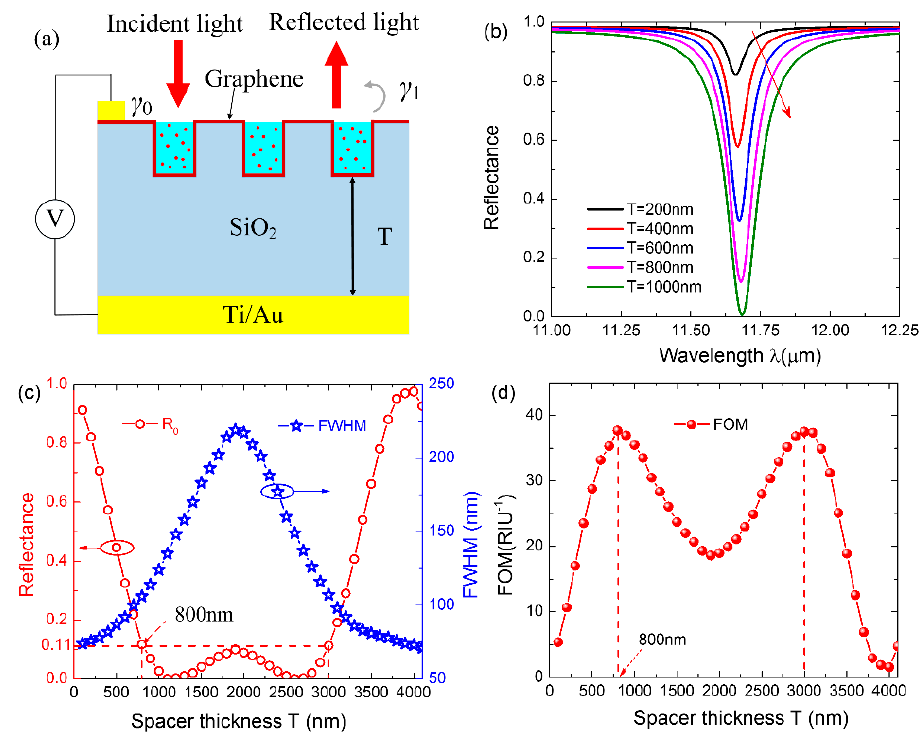
Figure 5. ( a ) Schematic of the reflection-type CGDNC infrared sensor; ( b ) The reflection spectra with varying spacer thickness T when Λ = 200 nm, H = 100 nm, W = 40 nm, and E f = 0.3 eV; ( c ) The extracted R 0 and fwhm from the reflection spectra with varying spacer thickness; ( d ) The calculated FOM with varying spacer thickness.